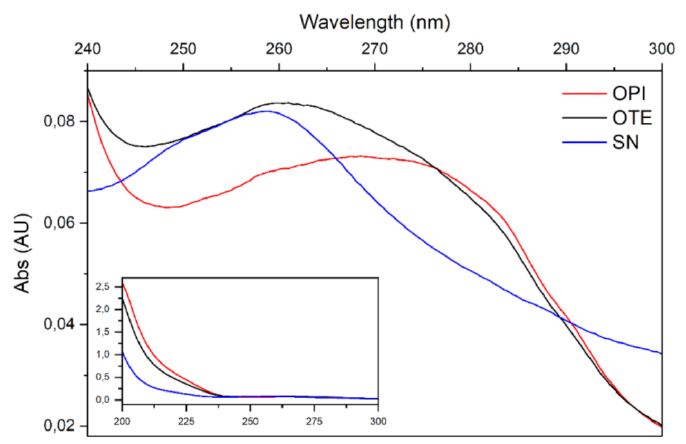
Figure 4. Spectra recorded from 240 to 300 to nm. OTE spectrum (black line) is the result of the sum of two components, one enriched with proteins (OPI, red line), one enriched with molecules with maximum absorption at 260 nm (SN, blue line). In the inset, the full spectrum (200–300 nm) is